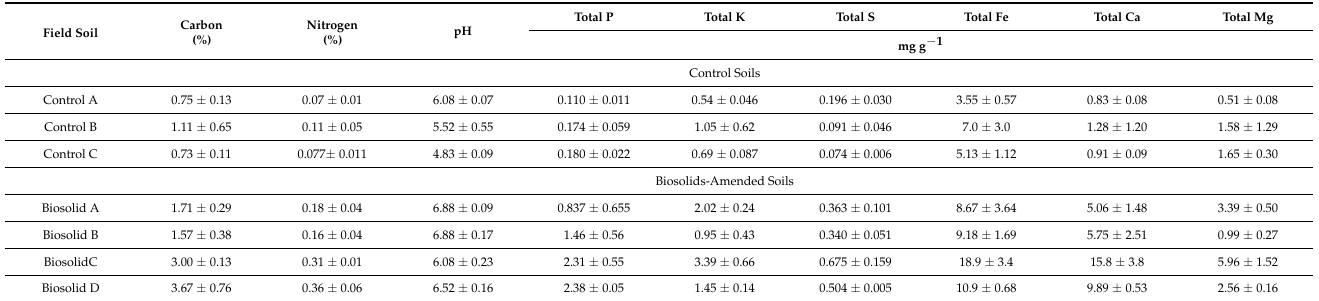
Table 2. Chemical properties of studied Oklahoma control and biosolids-amended